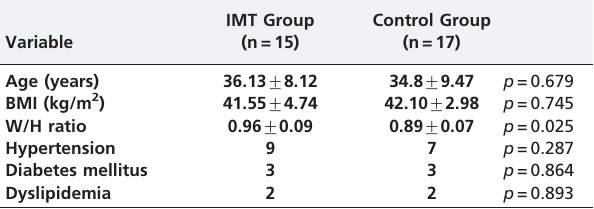
Table 1 - Baseline characteristics (values expressed as mean and SD).